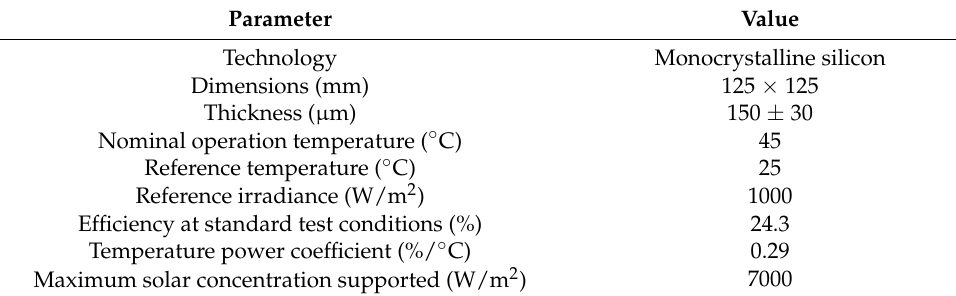
Table 3. Characteristics of the photovoltaic cells [39]. Parameter